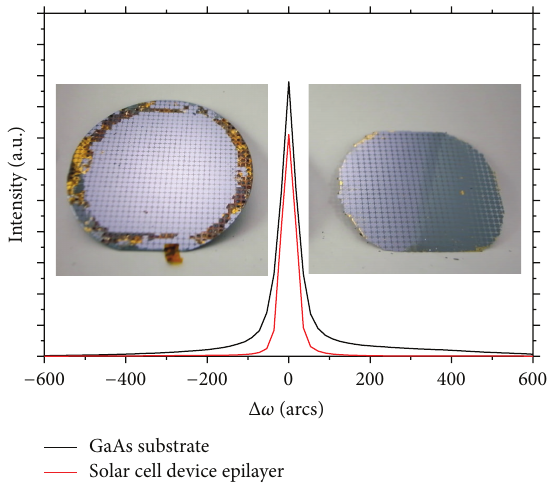
Figure 2: (004) XRD rocking curves of solar cell device epilayer and GaAs substrates (the 𝑦 -axis is shown in linear scale).The left insert figure is GaAs substrate after epitaxial lift-off and without chemical cleaning; right insert figure is solar cell device epilayer transferred to the Ni